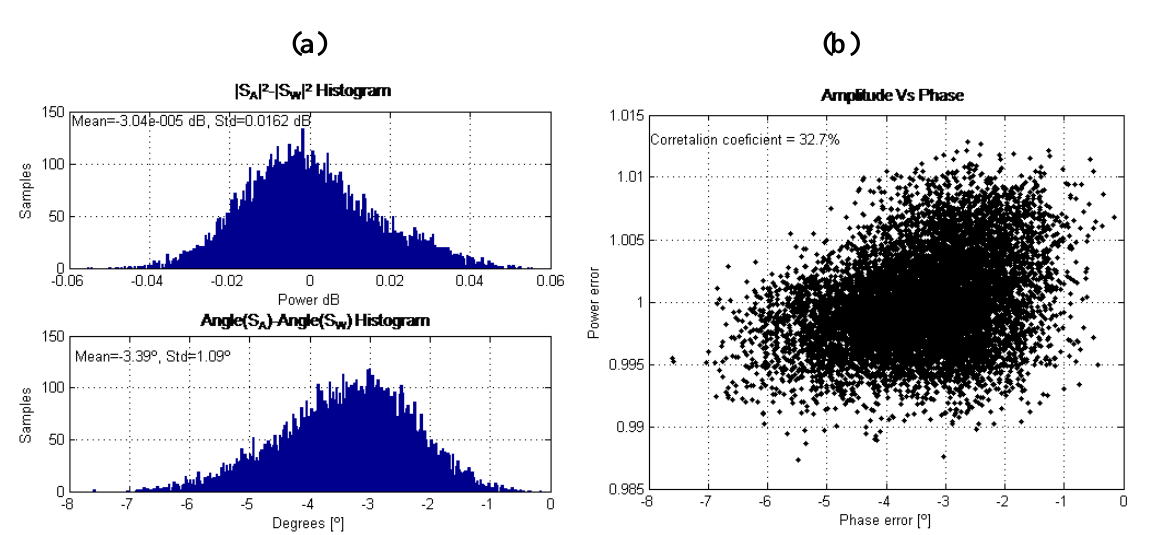
Figure 15. PAU-RAD DBF results. (a) Synthesized beam stability (fluctuations due to unitary receivers); the standard deviation of the amplitude is 0.0162 dB and of the phase is 1.09°. (b) Synthesized beam correlation between the amplitude and phase error, the plot shows that there is some correlation (32.7%). The data set consists of 30 minutes of data with the beam steering at 0º with no azimuth scan; each sample has an integration time of 100